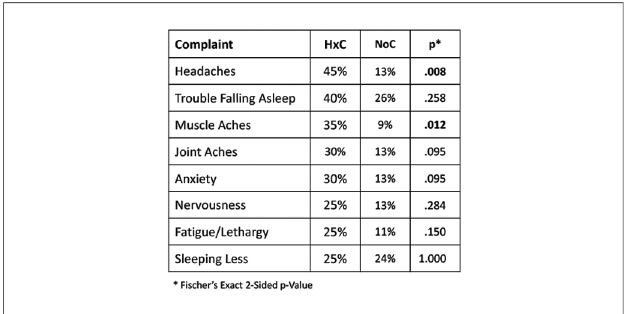
FIGURE 4 Most common complaints among self-reported history of concussion (HxC) cases, with corresponding frequency of each complaint for no concussion (NoC) cases.